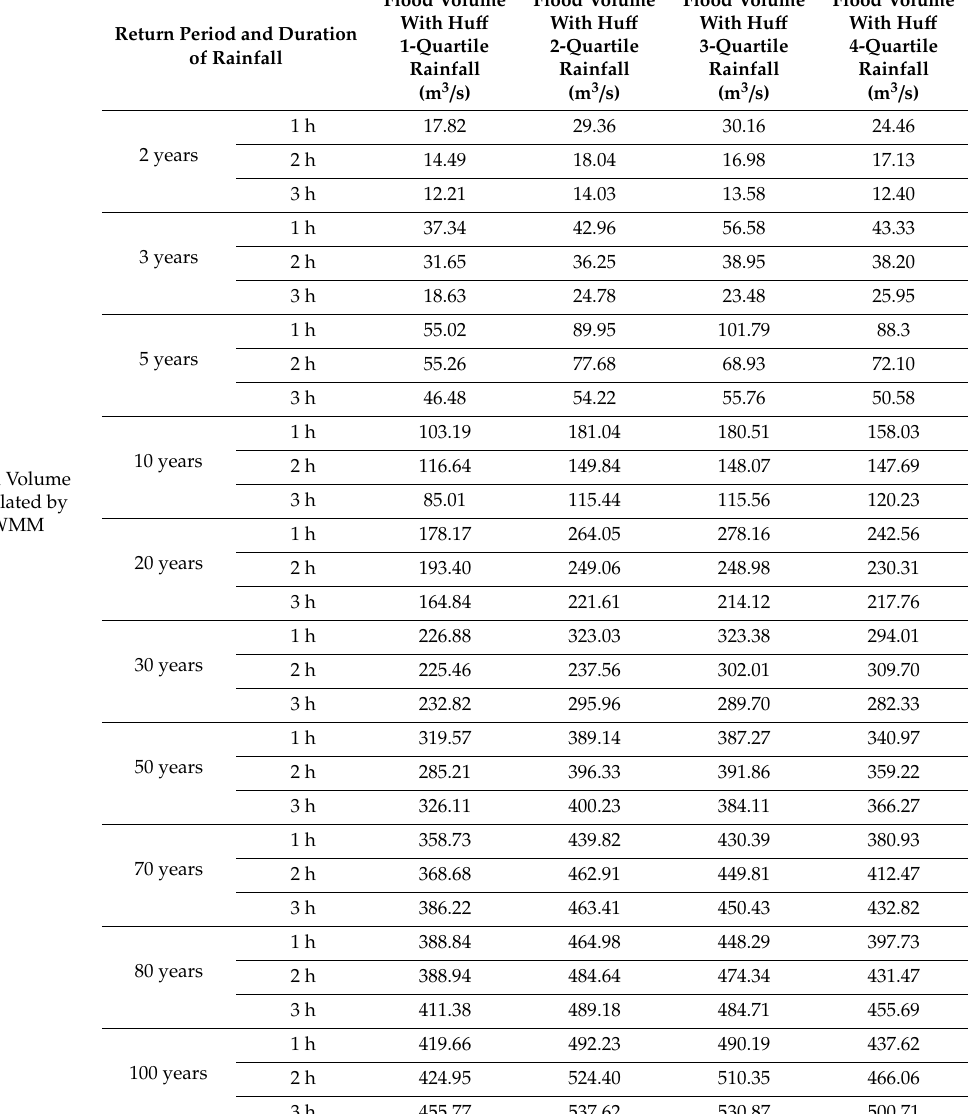
Table 2. Flood volume database simulated by the Storm Water Management Model